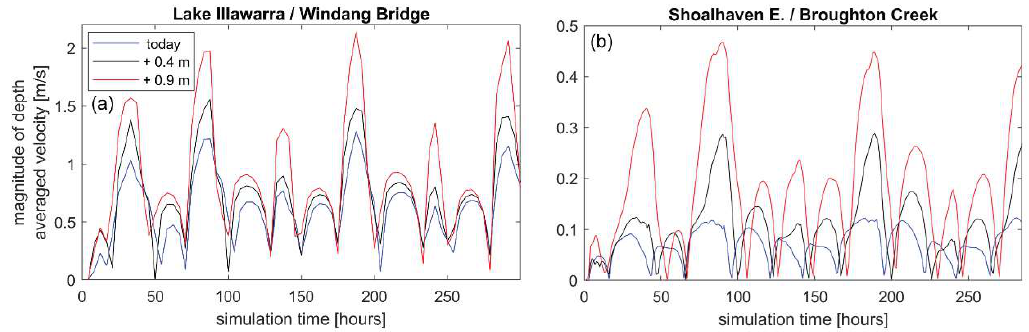
Figure 6. Simulated magnitude of depth-averaged current velocities for spring-tidal conditions and SLR scenarios over 6 tidal cycles at Windang Bridge in Lake Illawarra ( a ) and Broughton Creek in the Shoalhaven Estuary ( b ).